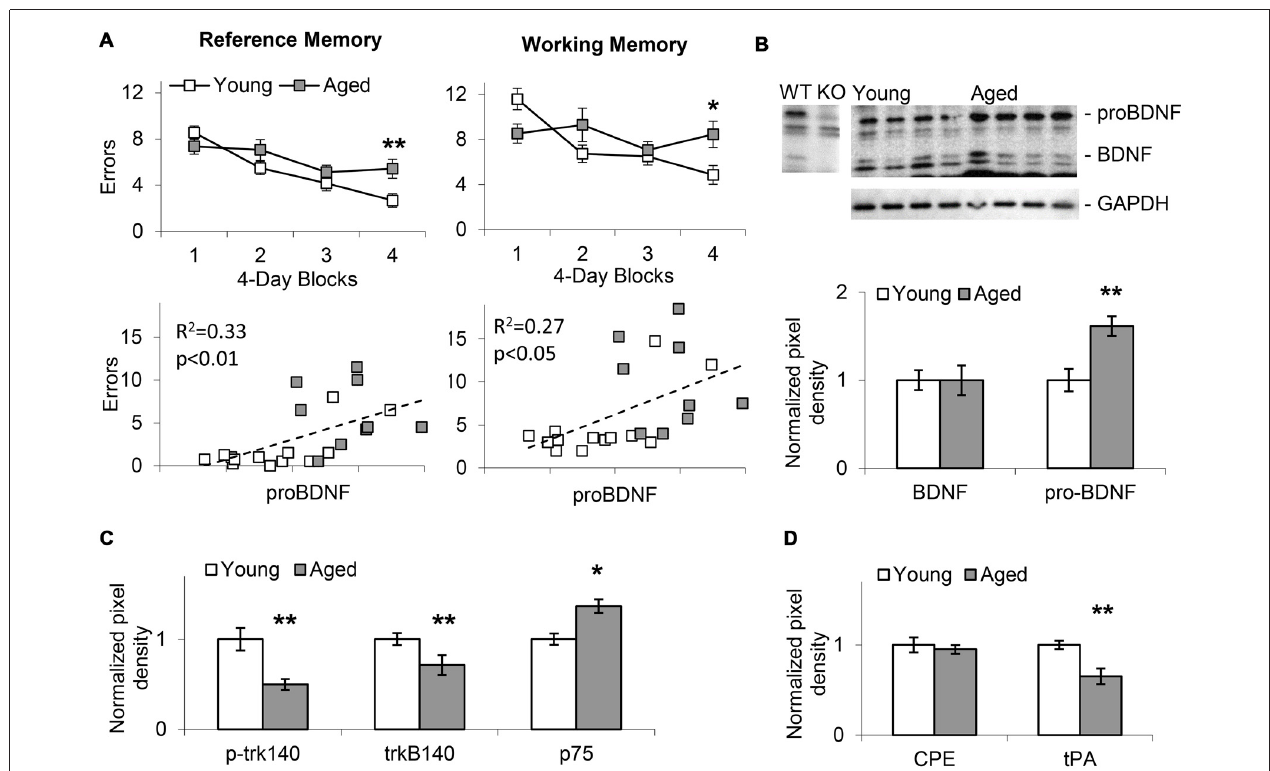
FIGURE 2 | Memory impairment in aged mice positively correlates with increases in hippocampal proBDNF levels. (A) Average ( ± SEM) reference memory (RM) and working memory (WM) errors over four 4-session blocks of a WRAM task in 24-month old aged mice and 4-month old young mice. RM and WM errors positively correlate with proBDNF levels. (B) Increase in proBDNF, but not brain-derived neurotrophic factor (BDNF), in 24-month old aged mice relative to young 4-month old mice. (C) Relative to young 4-month old mice, aged 24-month old mice show increased p75 Neurotrophin Receptor (p75NTR) and decreased p-trk140 and trk140. (D) Relative to young 4-month old mice, aged 24-month old mice show decreased Tissue Plasminogen Activator (tPA), but not carboxypeptidase E (CPE). ∗ p < 0.05; ∗∗ p <